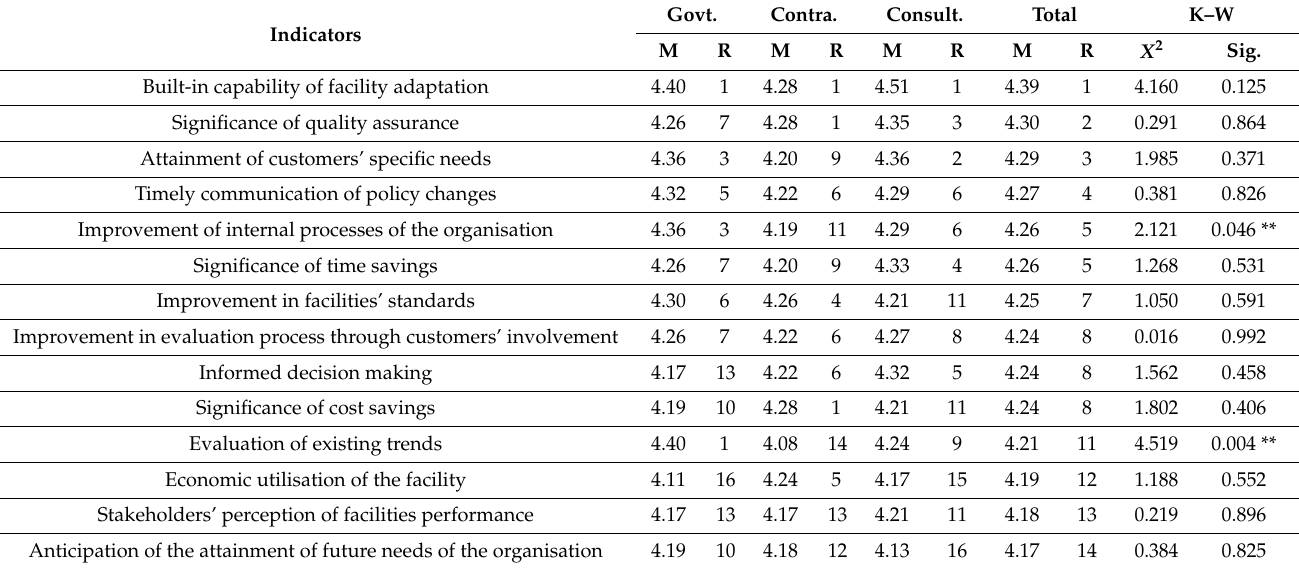
Table 1. Performance Measurement (Mean Ranking and Kruskal–Wallis